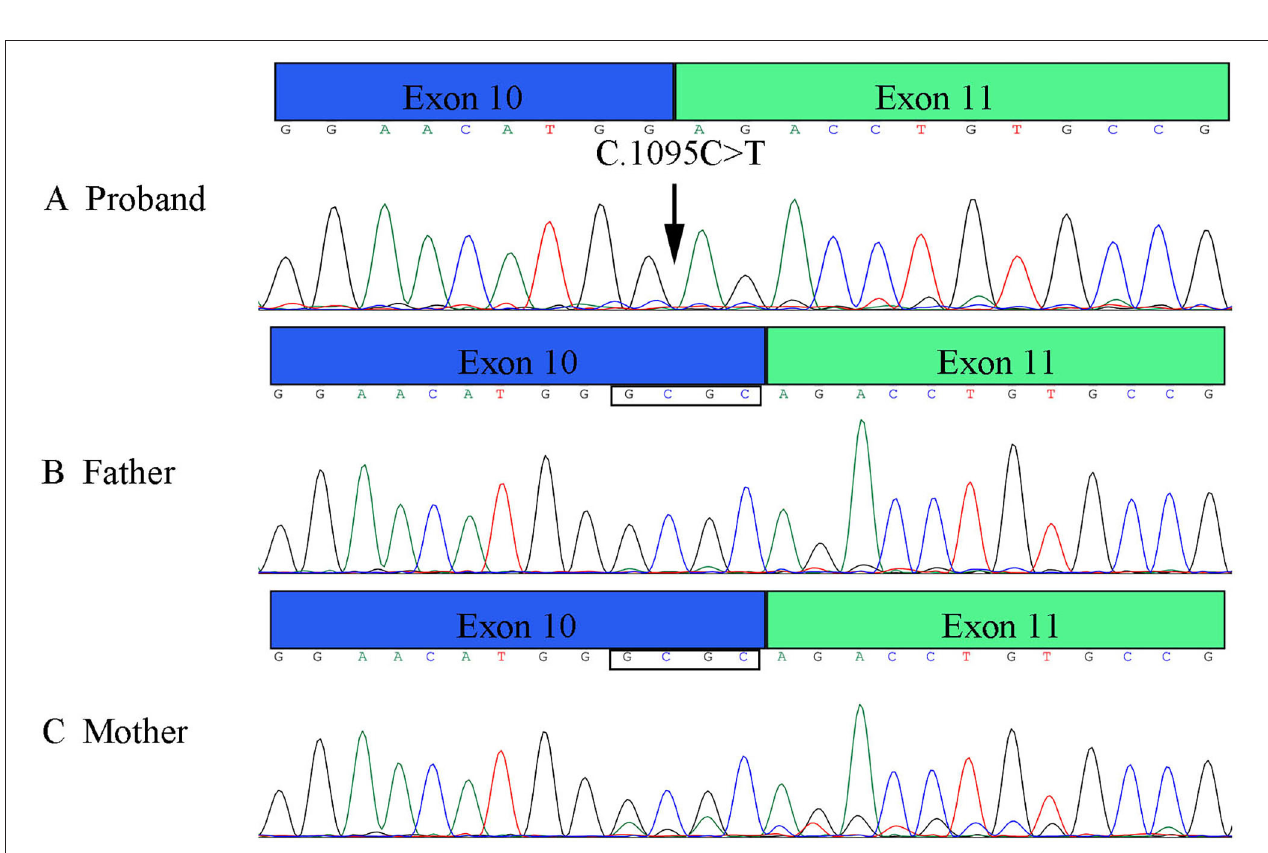
FIGURE 5 | Results of RT-PCR of PLOD1 variant in pedigree. (A) The proband variant resulted in a premature termination codon of exon 10 and affected the expression of the four bases GCGC. (B,C) Parents’ cDNA at exon 10 and exon 11.